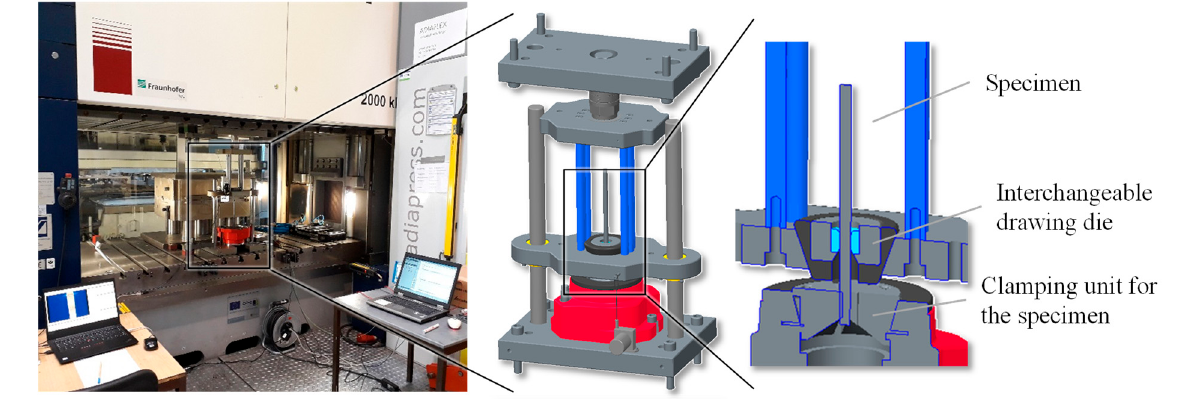
Figure 2. Tool principle—interchangeable dies for different geometry variants. The formed samples were analyzed by the X-ray diffraction method (XRD) and com- pared with the initial state. The residual stress states were determined in order to study